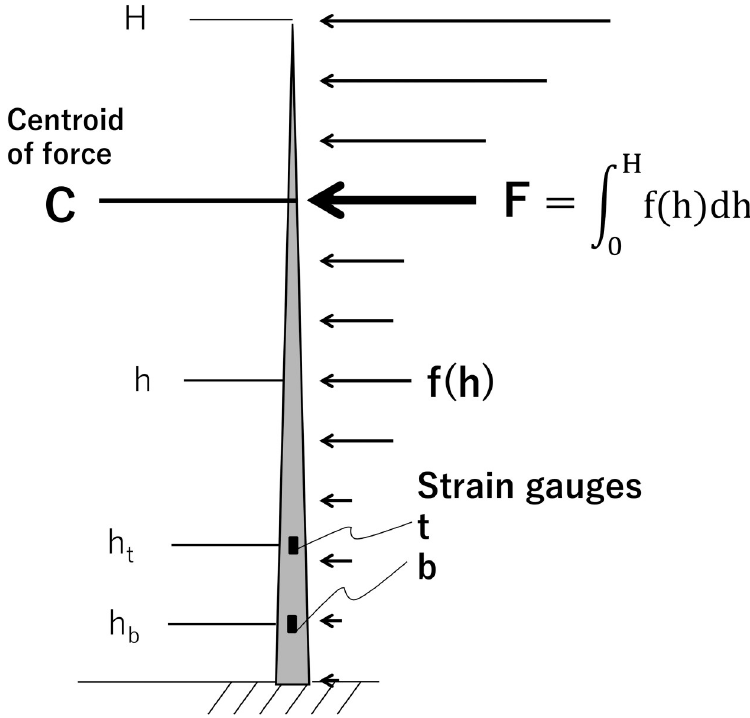
Fig 1. Schema for the wind force acting on a tree. Wind force has a distribution pattern. f(h), a force acting at height h; F, amount of distributed wind force; C, height of the centroid of the distributed force. Strain gauges are attached at h t and h b . H is the tree